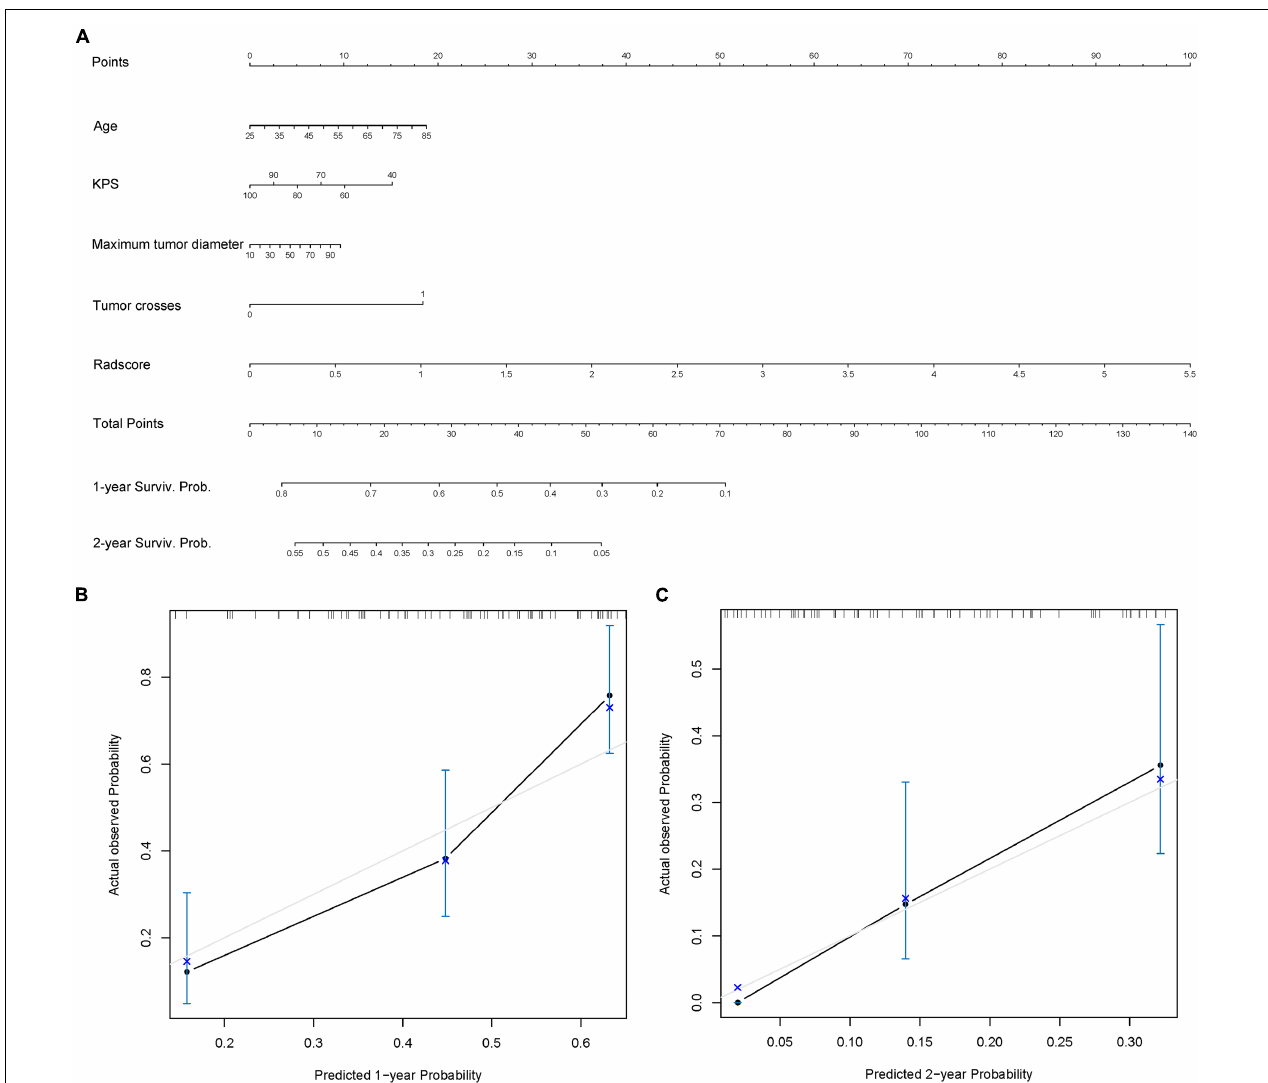
FIGURE 5 | Radiomics nomogram. (A) Radiomics + Clinical nomogram constructed by integrating the independent risk factors, including age, Karnofsky performance status (KPS), maximum tumor diameter, tumor crossing the midline, and radscore to predict the 1- and 2-year survival of patients with isocitrate dehydrogenase (IDH)-wild-type glioblastoma (GBM). (B,C) Calibration curves used to assess the prediction consistency of the nomogram in the training set (B) and the test set (C)